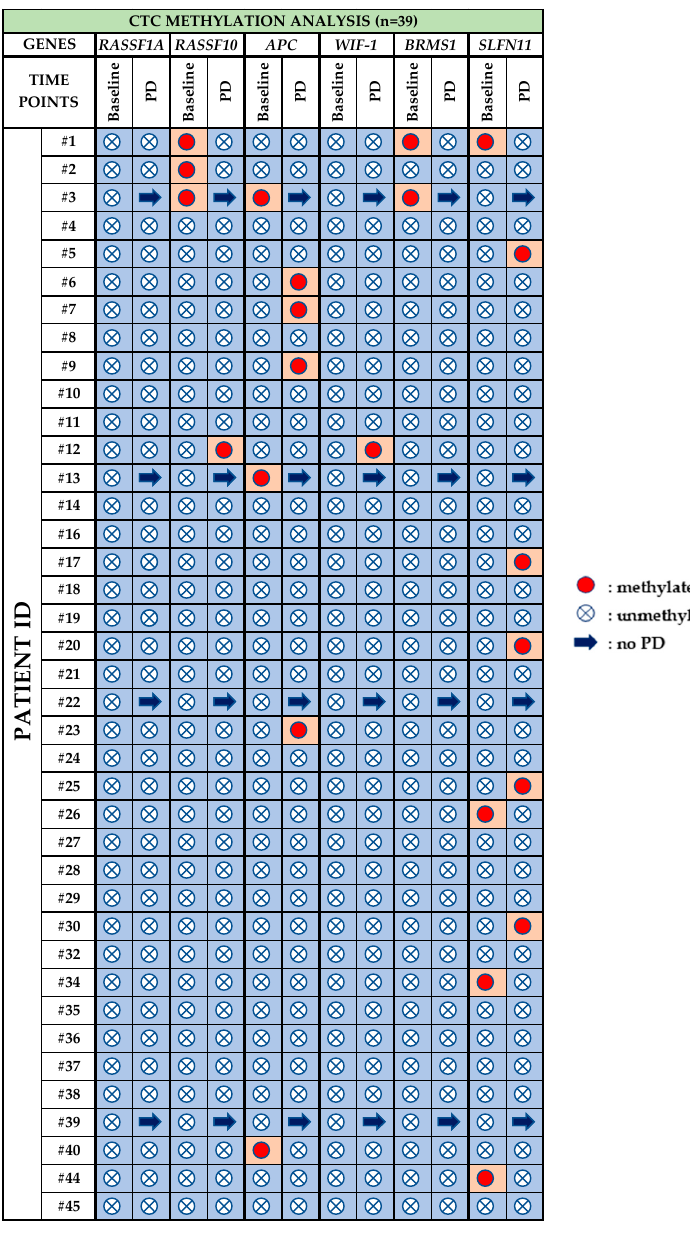
Figure 5. Methylation status of six selected genes in CTCs of NSCLC patients before osimertinib initiation ( n = 39) and at progression of disease ( n = 35).